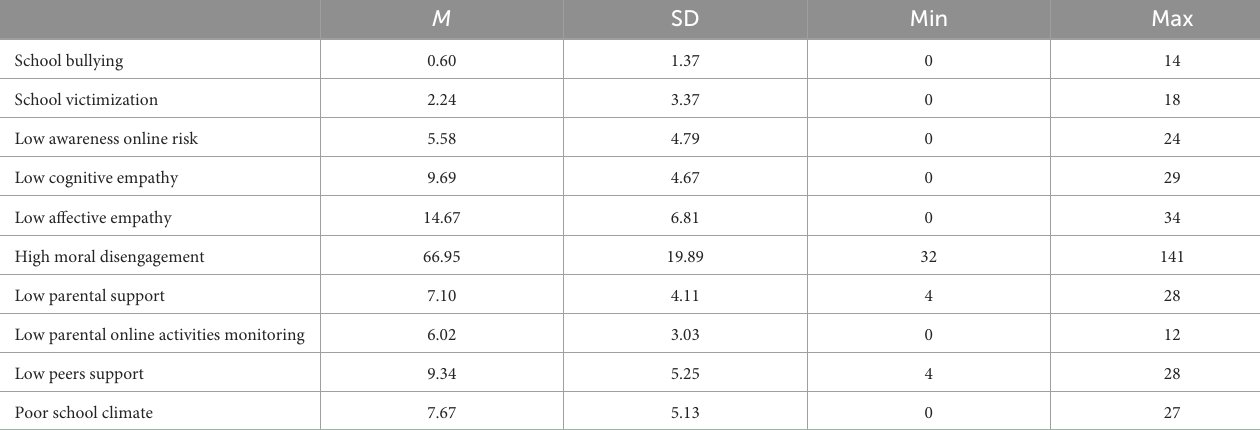
TABLE 1 Descriptive statistics of onset cyberbullying ( N =